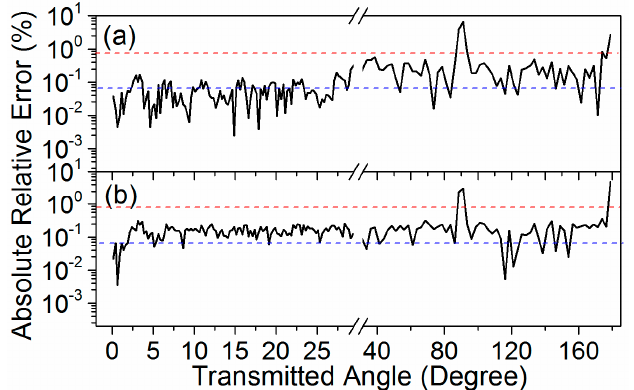
Figure 8. Absolute relative error of Markov chain approximations compared to Monte Carlo simulations with zenith angle discretization scheme 2. Phase function 3 was selected. Panel. ( a ) OD = 2, Panel. ( b ) OD = 5. The angular resolution was 0.25° for θ < 30° and 2.5° for θ > 30°.